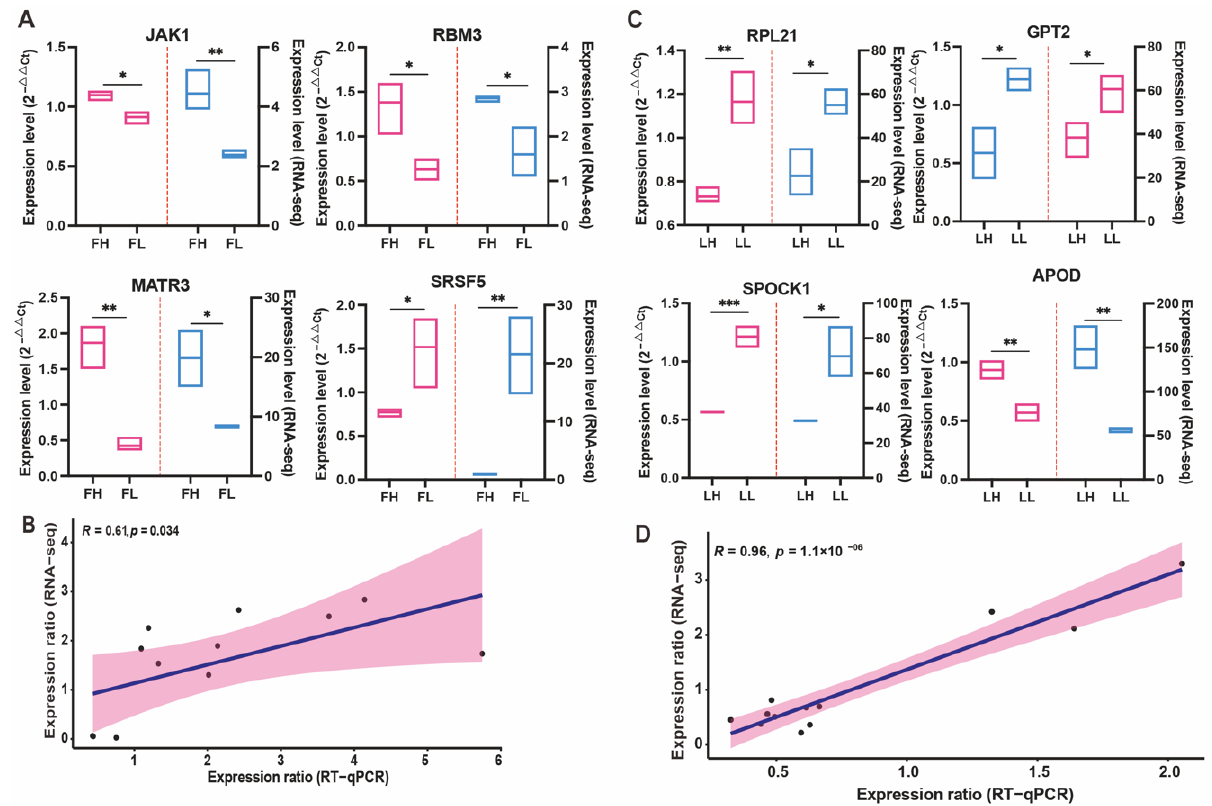
Figure 8. Protein and mRNA expression profiles of the protein candidates were validated by RT-qPCR in FH vs. FL ( A ) and LH vs. LL ( C ) comparison groups. Scatter plots show the correlation of gene expression between RNA-Seq and RT-qPCR in FH vs. FL ( B ) and LH vs. LL ( D ) comparison groups; Pearson correlation coefficient (R) and the p value is shown in the top left corner. * p < 0.05, ** p < 0.01, *** p < 0.001.